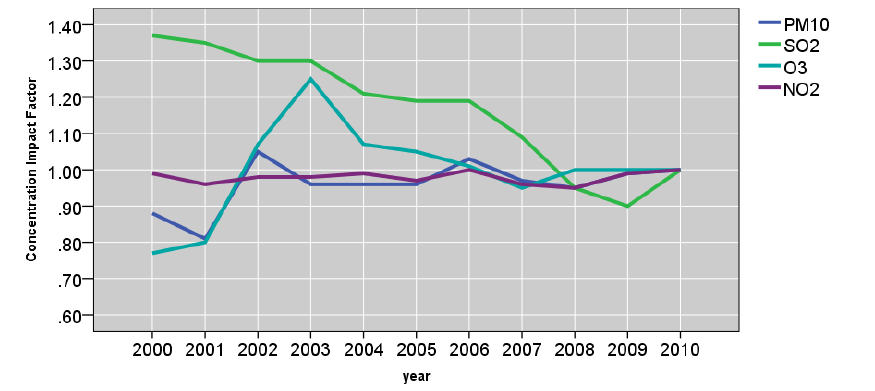
Figure 9. Yearly concentration impact